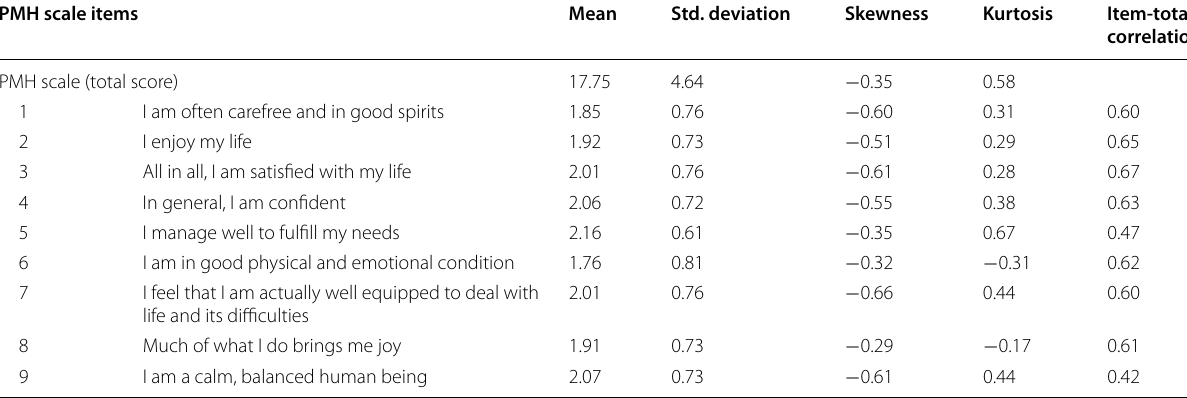
Table 2 Item statistics for the Positive Mental Health (PMH) scale PMH scale